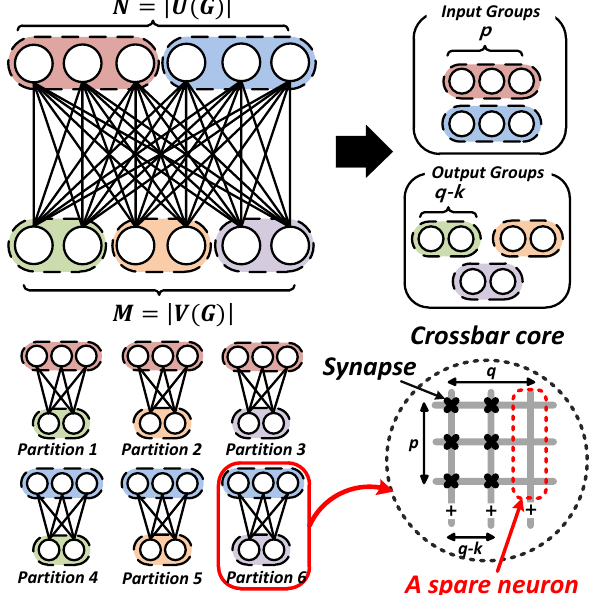
Figure 4. k -Spare Decomposition Algorithm ( k